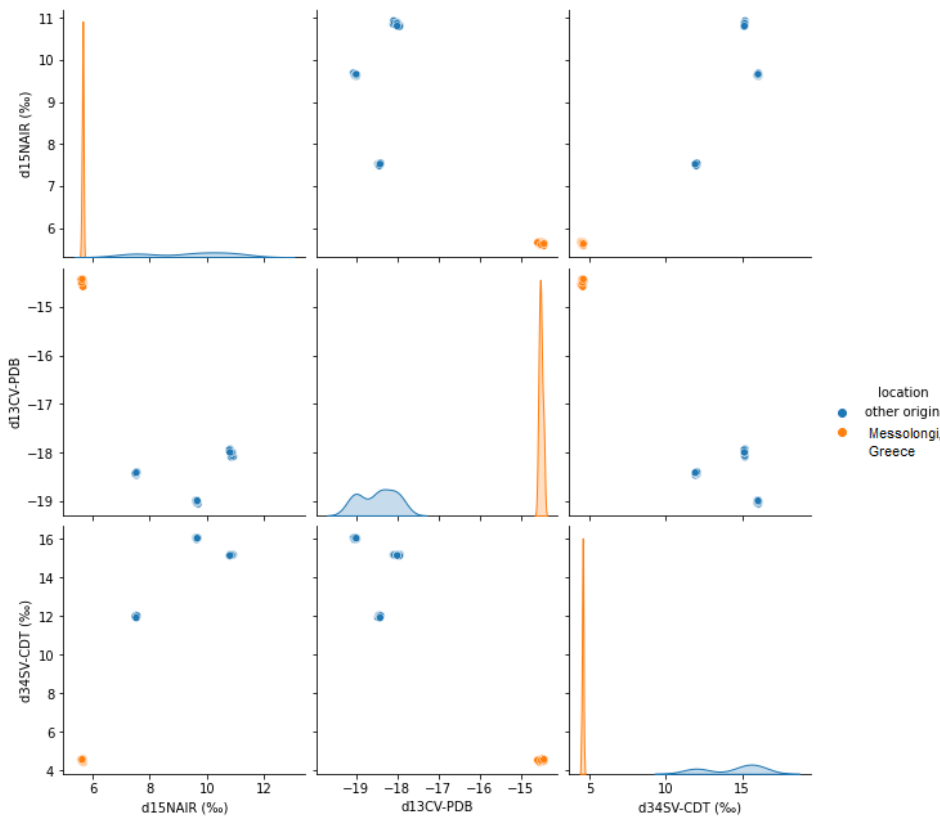
Figure 2. Scatter plots of all measured bottarga samples. Main diagonal shows kernel density estimations.